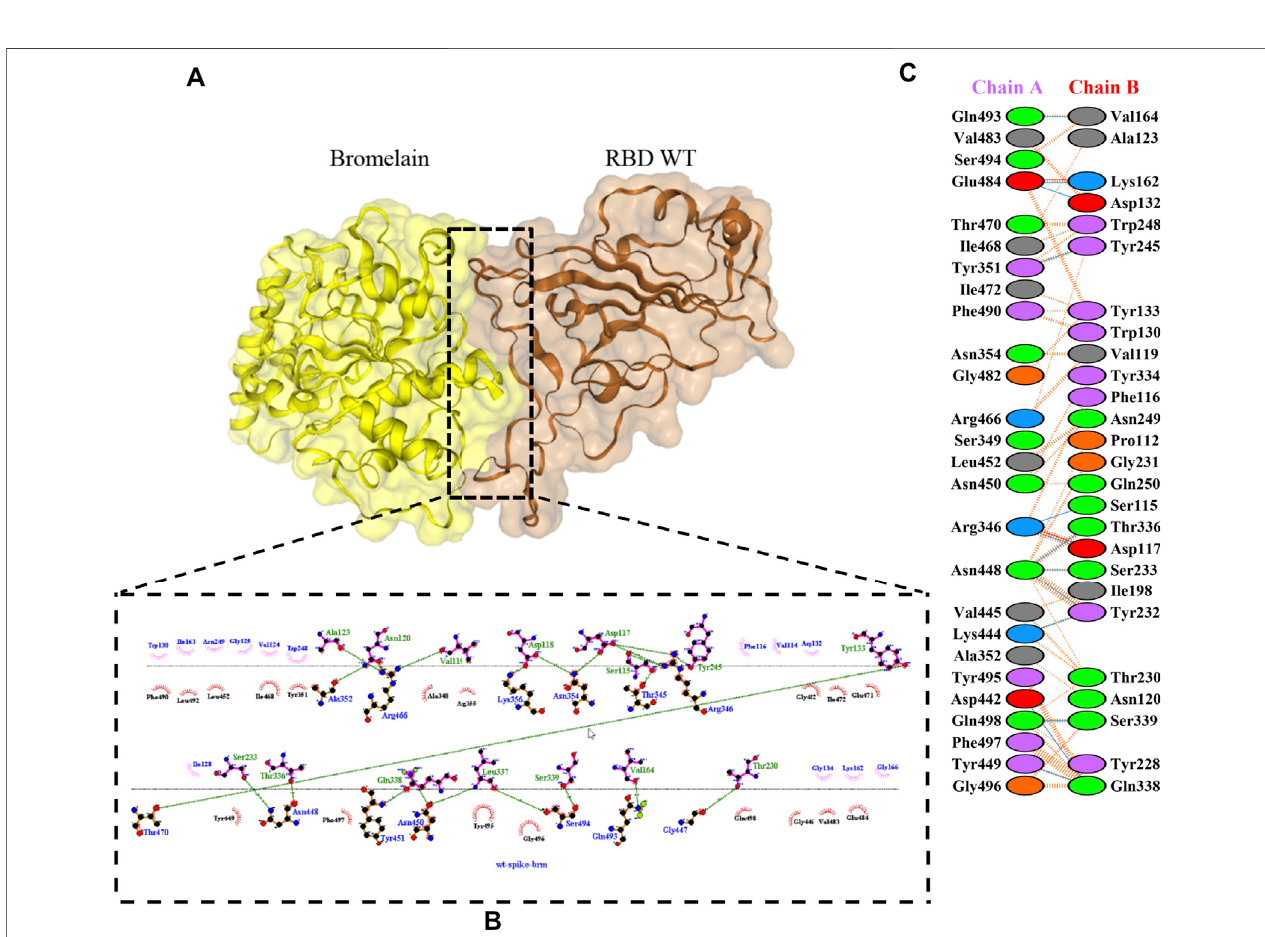
FIGURE 4 | Docking representation of the WT and bromelain complex. (A) the binding interface of the complex, (B) the binding interaction between the amino acids, and (C) interaction representation including hydrogen, salt bridges, and nonbonded interactions. Chain A is RBD WT and chain B is bromelain.